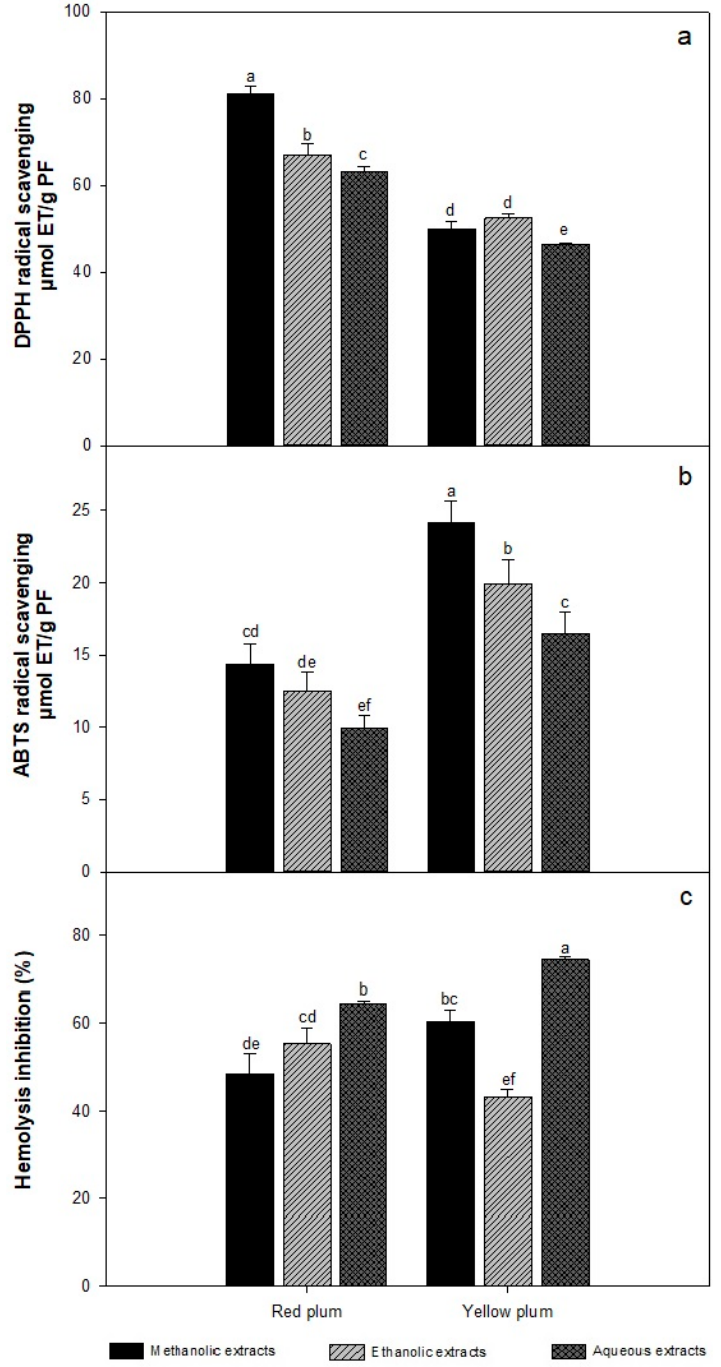
Figure 2. Antioxidant capacities of methanolic, ethanolic and aqueous extracts of red and yellow plum variety determined by DPPH ( a ), ABTS ( b ) and PHI ( c ) assays. The data are the mean values of at least three determinations n = 3) ± standard deviation (error bars). Bars with different letters are significantly different ( p ≤ 0.05).